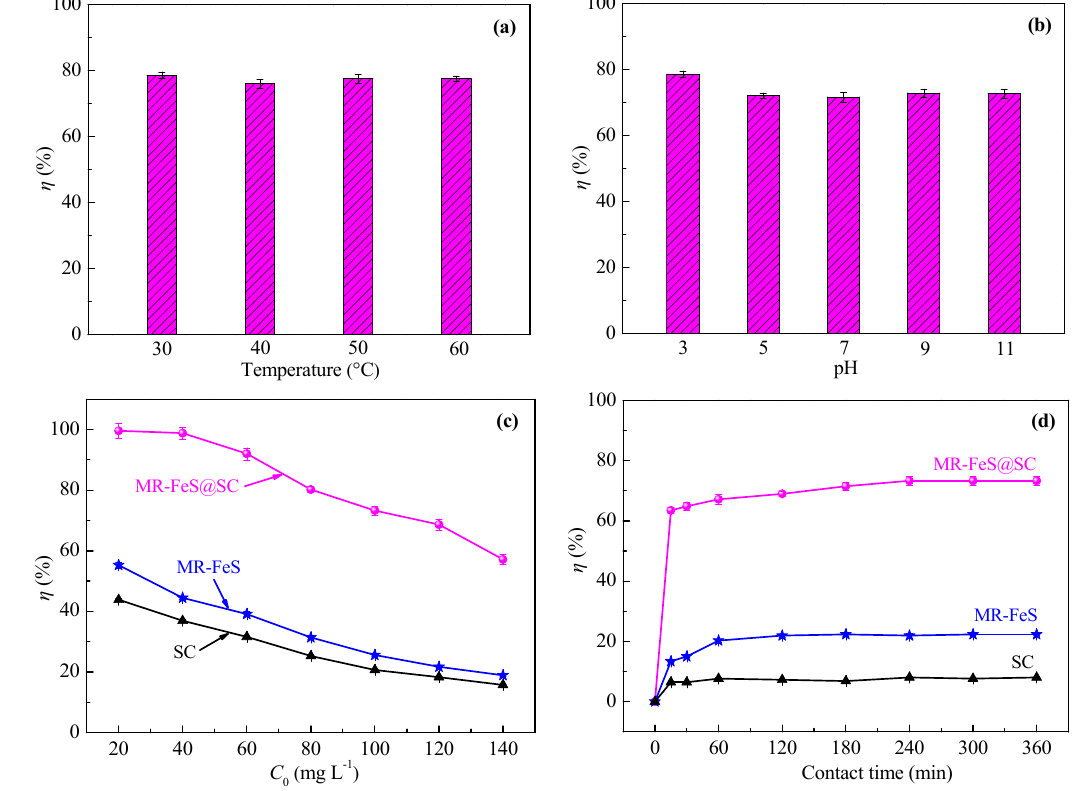
Figure 8. ( a ) Effect of temperature on the removal efficiency of Safranine T (ST) by MR – FeS@SC (adsorbent dosage = 0.8 g L − 1 , C 0 (ST) = 100 g L − 1 , pH = 7.0, and contact time = 360 min); ( b ) effect of pH on the removal efficiency of ST by MR – FeS@SC (adsorbent dosage = 0.8 g L − 1 , C 0 (ST) = 100 g L − 1 , temperature = 30 °C, and contact time = 360 min); ( c ) effect of initial ST concentration on the removal efficiency of ST by different adsorbents (adsorbent dosage = 0.8 g L − 1 , temperature = 30 °C, pH = 7.0, and contact time = 360 min); and ( d ) effect of contact time on the removal efficiency of ST by different adsorbents (adsorbent dosage = 0.8 g L − 1 , C 0 (ST) = 100 g L − 1 , temperature = 30 °C, and pH = 7.0).